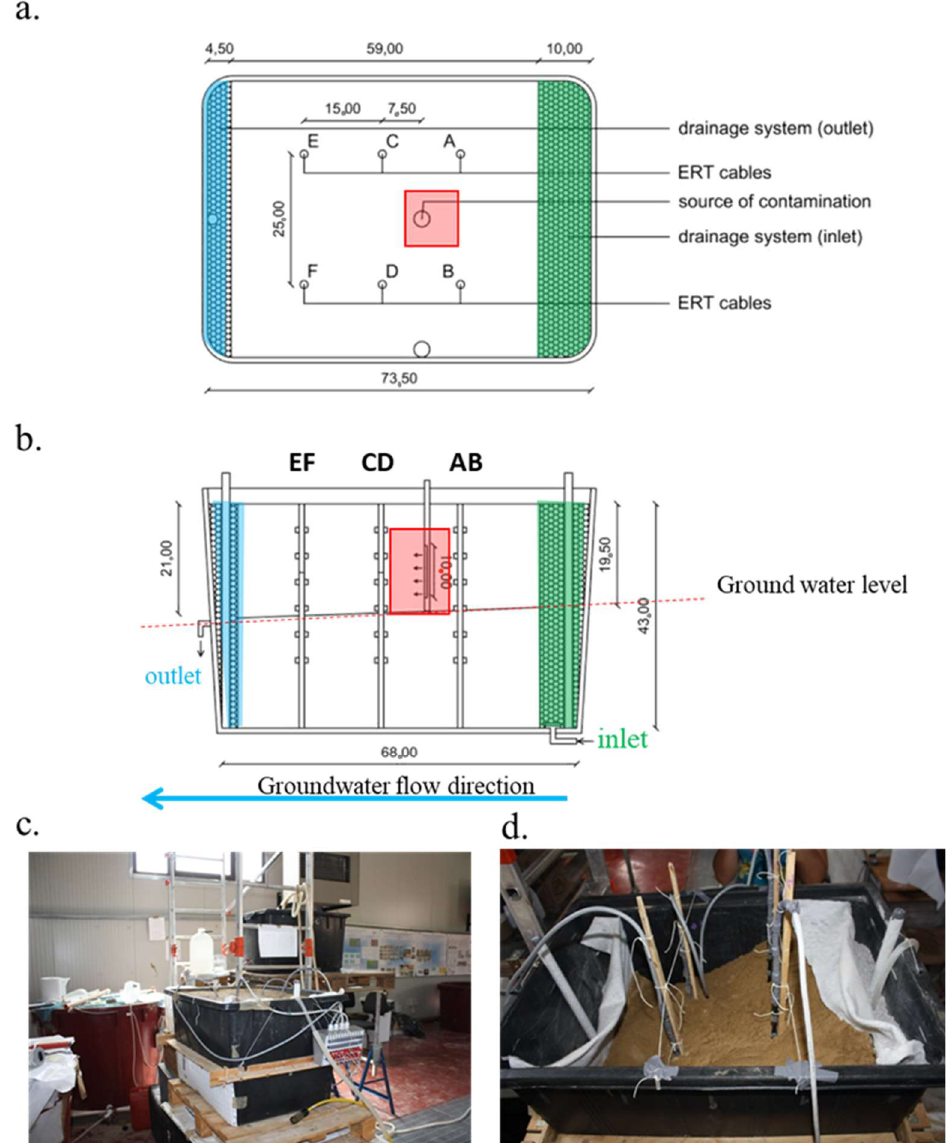
Figure 1. Plan of the test site with indications of the three borehole couples (AB-CD-EF) ( a ); vertical section of the box with contamination zone highlighting (red rectangle) and identification of the recharge and discharge systems (green and blue rectangle, respectively) ( b ); photo of laboratory test site ( c ) and detail of the geoelectrical boreholes used for the experiment ( d ).